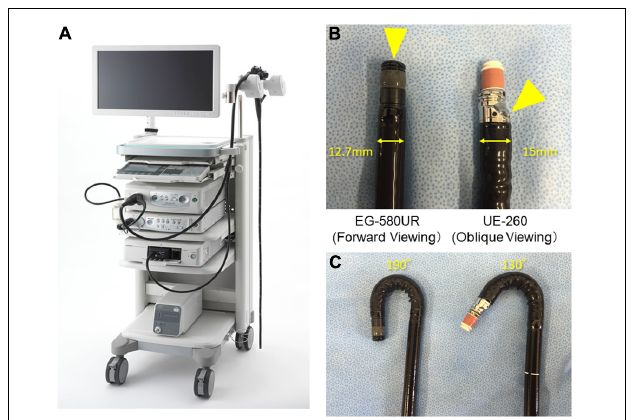
FIGURE 1 | Endoscopic ultrasound (EUS) system and differences between forward-viewing radial EUS (FR-EUS) and conventional radial EUS. (A) EG-580UR with SU-1 EUS System (Fuji Medical, Tokyo, Japan). (B) The optical lens is located at the front in FR-EUS but behind the ultrasound transducer in conventional radial EUS. (C) The degree of up angle of FR-EUS is 190 ◦ but 130 ◦ in conventional radial EUS.